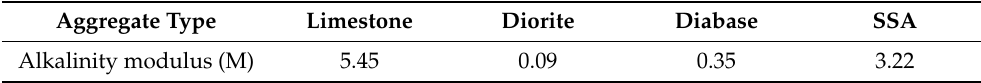
Table 5. Comparison of alkalinity modulus between SSA and other